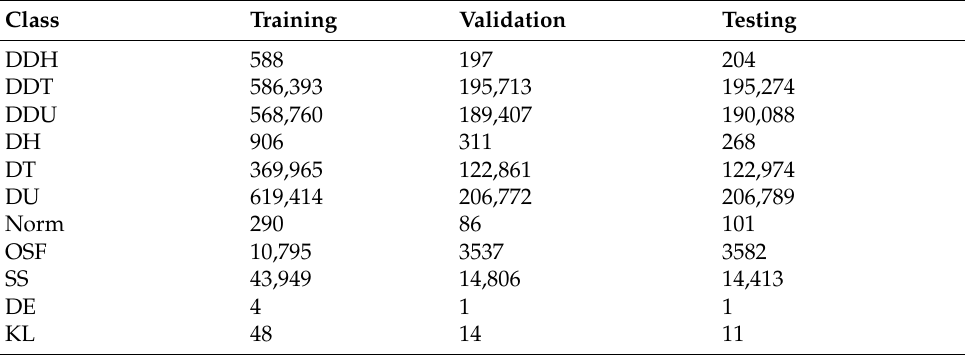
Table 2. Network traffic samples in the training, validation, and testing